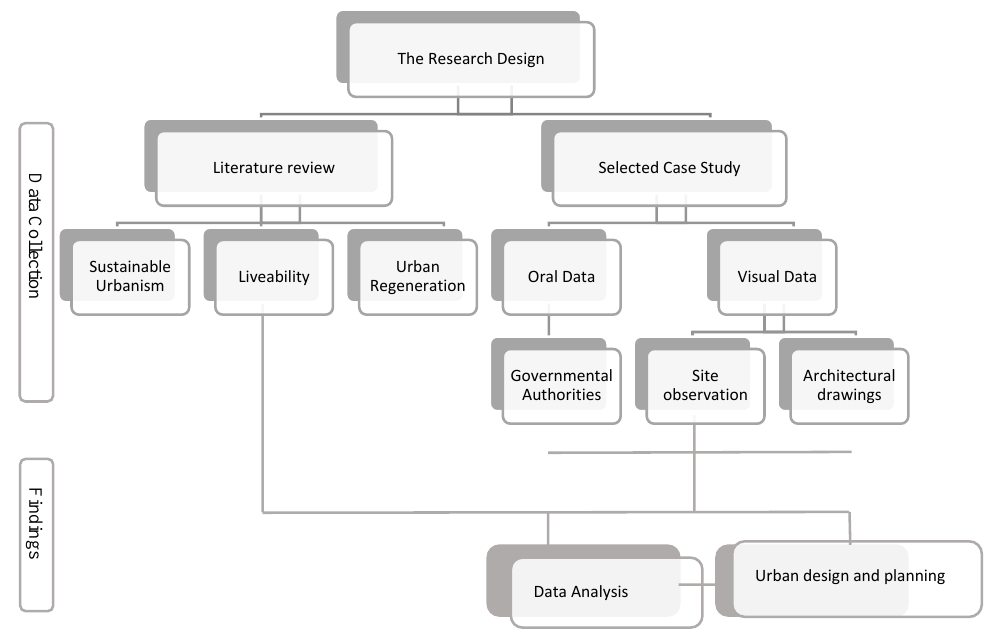
Figure 3. The research design diagram.